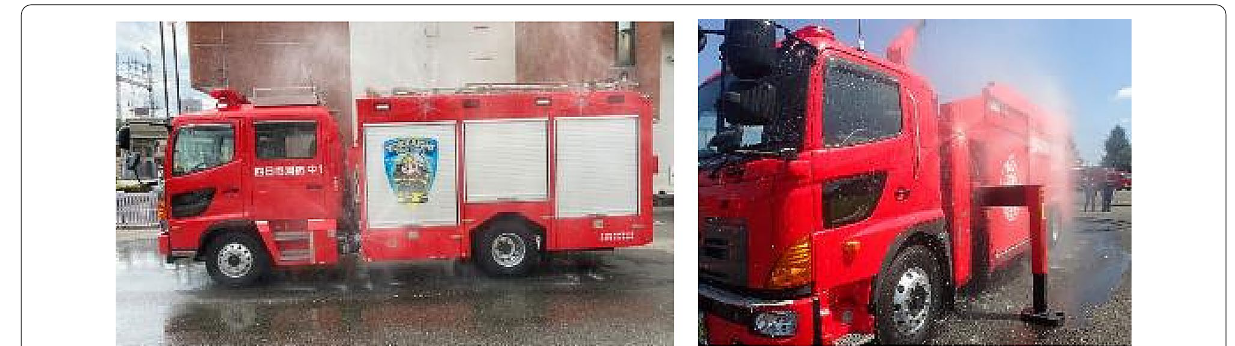
Fig. 3 Self-protection sprinkling system mounted on fire engines (photo courtesy: Yokkaichi City Fire Department and Ichihara City Fire